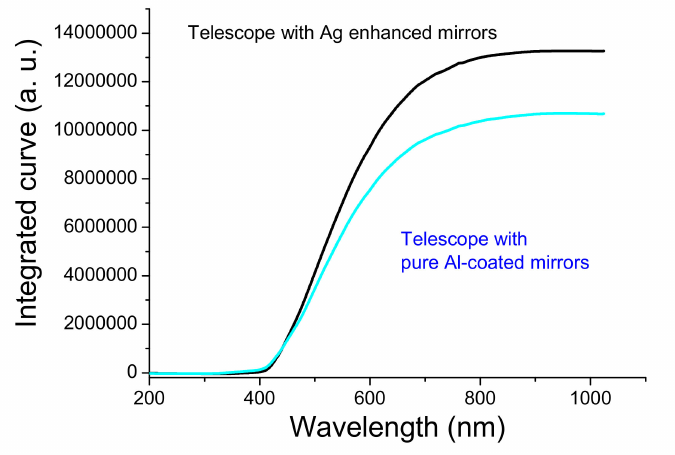
Figure 12. Integrated curves of the spectra of two exit pupils from double